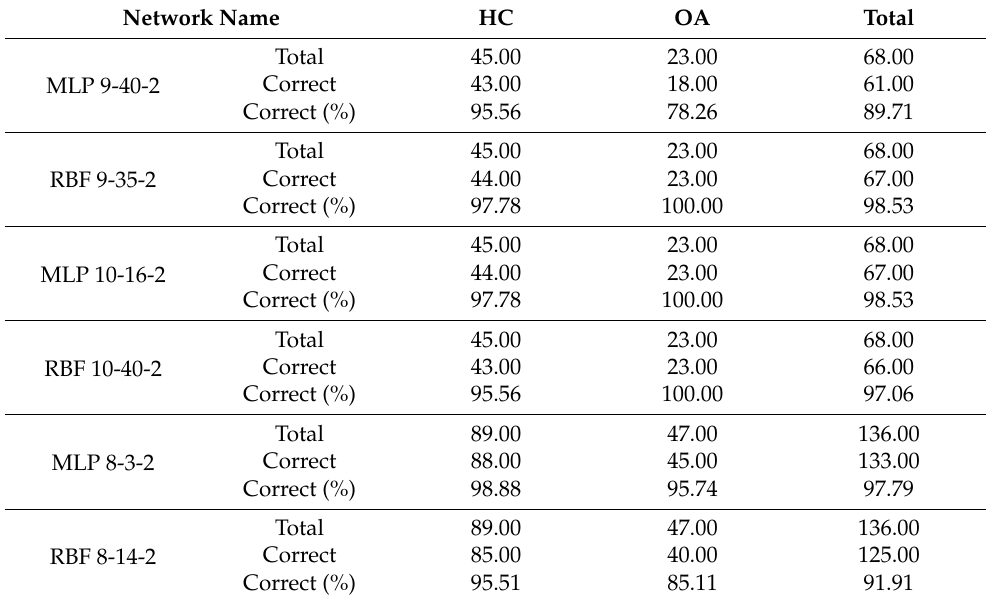
Table 3. Summary of the classification accuracy of the MLP and RBF networks for variant I, II and